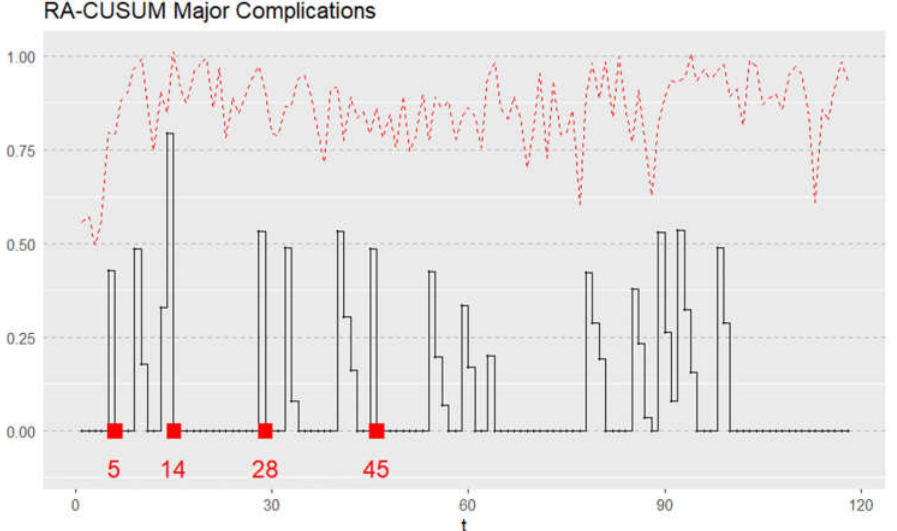
Figure 4. Risk-adjusted cumulative sum (RA-CUSUM) model for surgical failure considered in